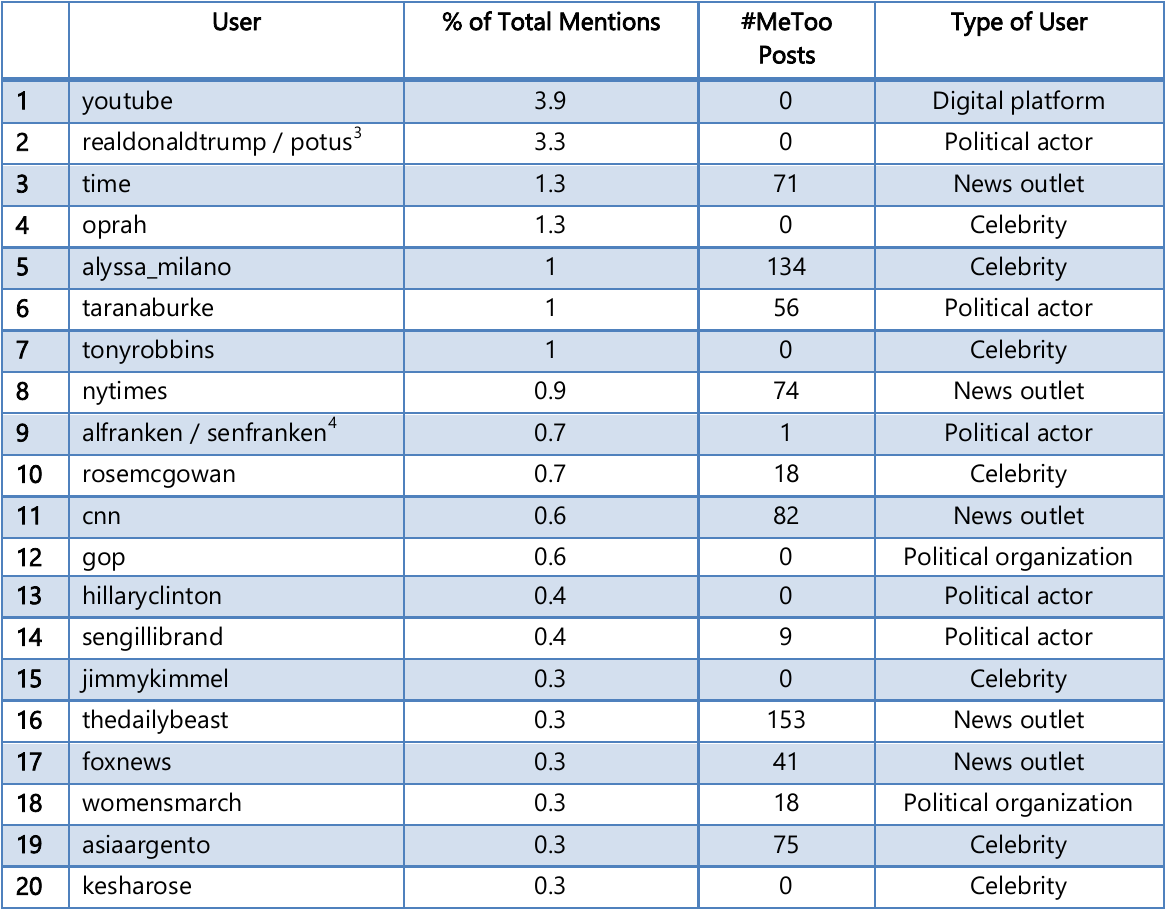
Table 1: Top 20 Most Mentioned Users vs. the Number of #MeToo Tweets They Posted 2 (Source: Authors‘